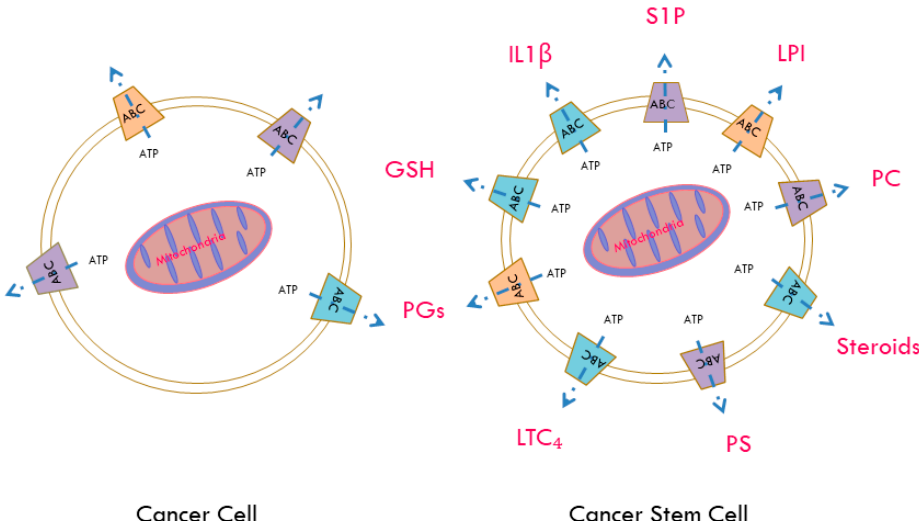
Figure 1. Potential signalling molecules released by ATP binding cassette (ABC) transporters in cancer stem cells. CSCs have an enhanced expression of ABC transporters, coupled with an increased mitochondrial ATP output. ABC transporters primarily use energy derived from ATP to carry out their functions. In addition to exporting a wide variety of drugs, contributing to the multidrug resistant phenotype, ABC transporters can export a variety of signalling molecules that may contribute to an overall enhanced survival advantage. For example, ABCC4 can export prostaglandins (PGs), whereas ABCC1 can export leukotriene C4 (LTC 4 ), sphingosine-1-phosphate (S1P) and lysophosphatidylinositol (LPI). It was recently found that ABCB5 can export interleukin 1 beta (IL1 β ) and ABCG2 can export androgens. Members of the ABCA family export phospholipids and have been implicated in intracellular lipid homeostasis. Additionally a variety of ABC transporters can export glutathione (GSH) and